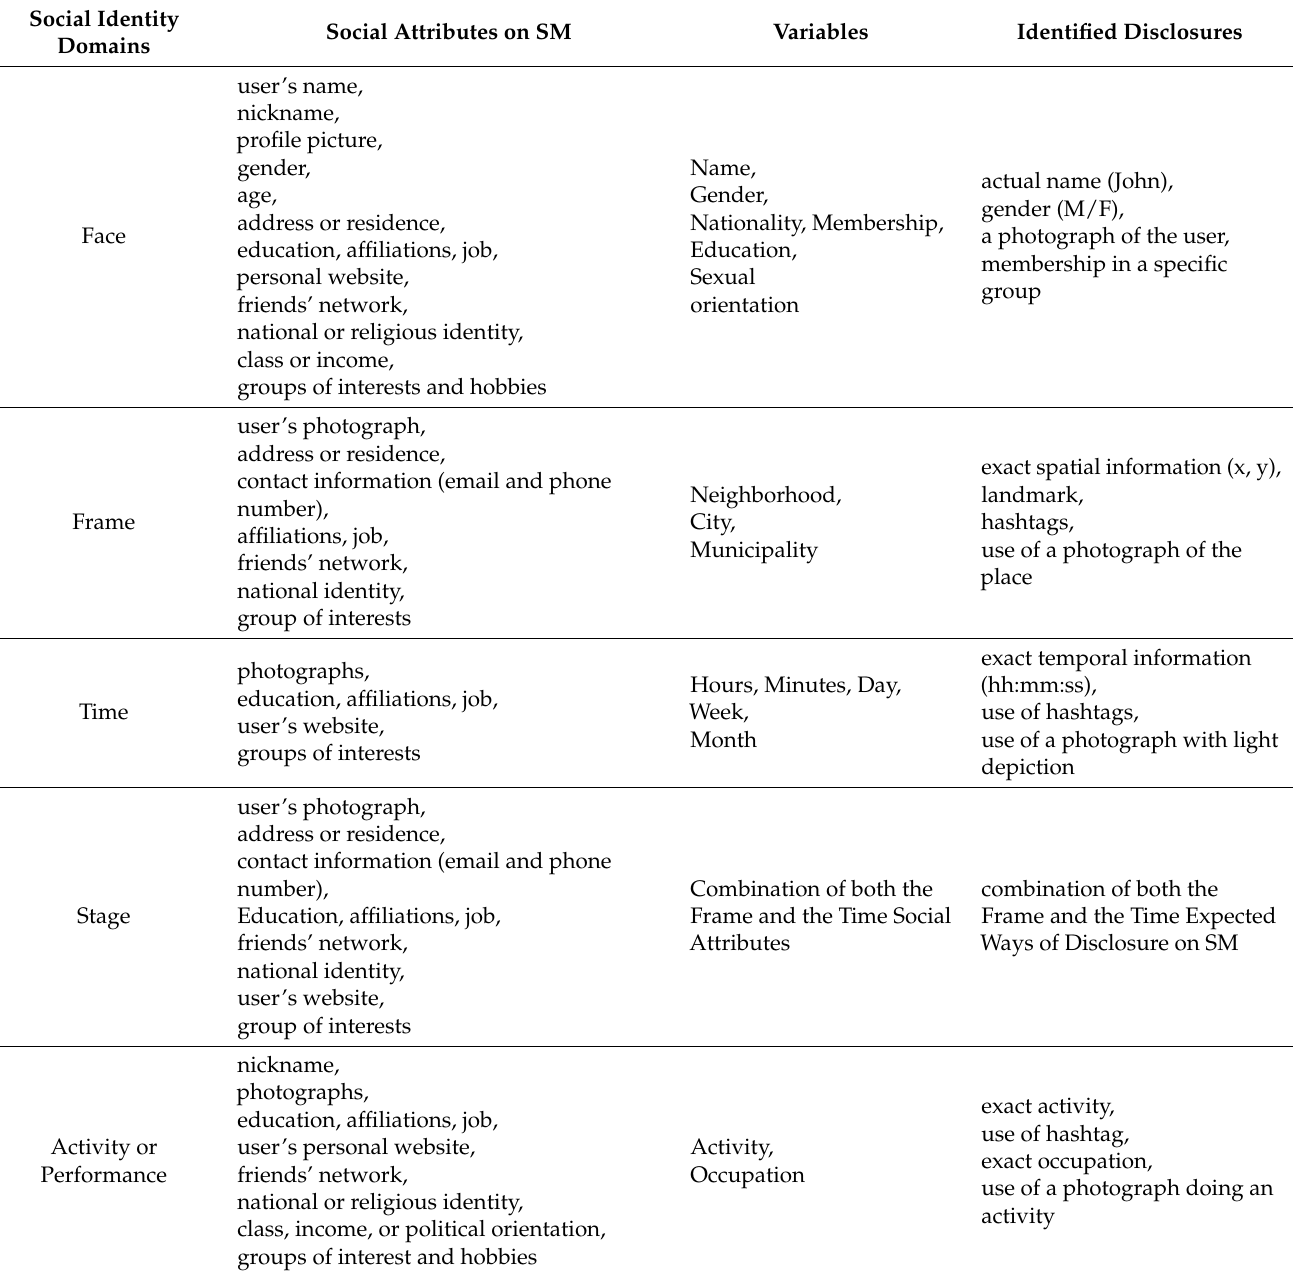
Table 3. SI Domains, Attributes, Variables, and Identified Disclosures on Social